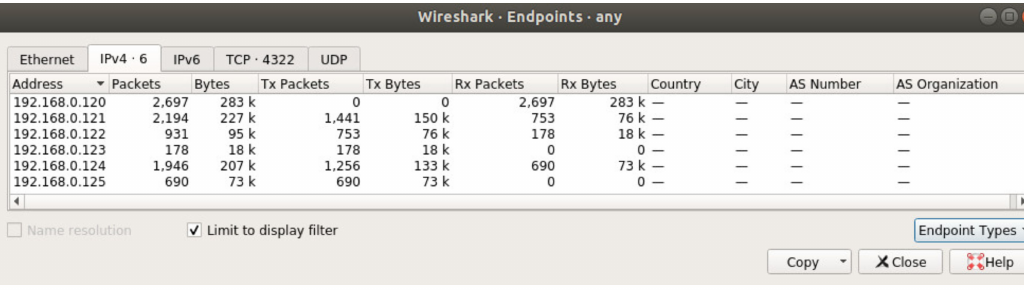
Figure 12. Statistics for optimized